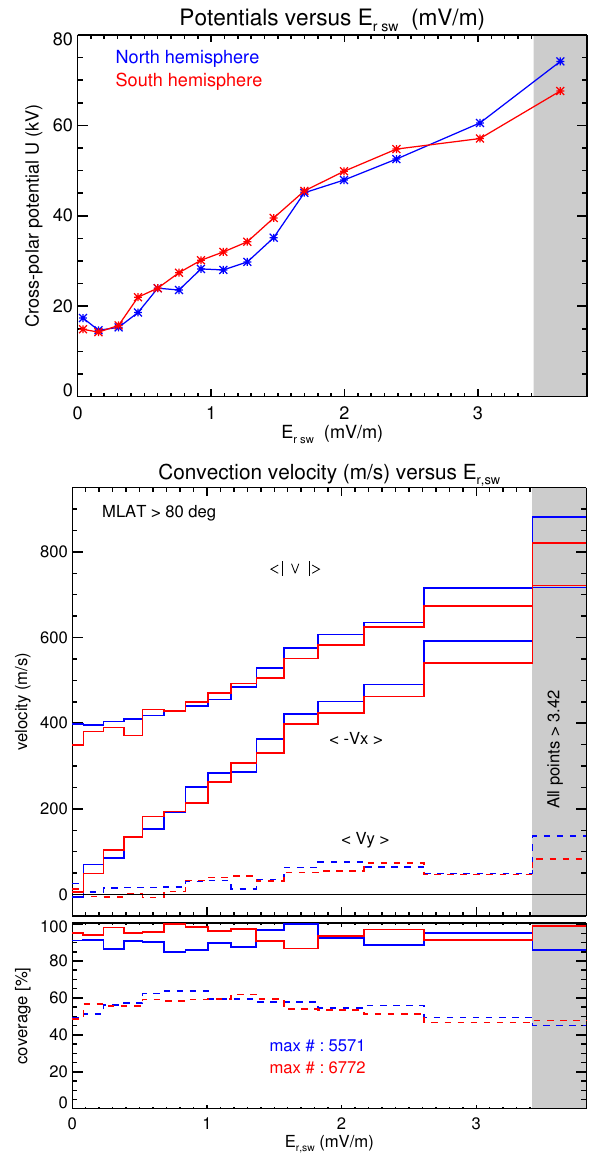
Fig. 9. Top: Cross-polar cap potentials as function of the solar wind reconnection electric field, E r,sw , for both North (blue) and South (red) high-latitude convection pattern, derived for each bin separately (cf. Paper 1). Here, again we use variable step widths as in Fig. 8. Middle: Central polar cap convection velocities for the same variable bin steps as above, but averaged within the central polar cap at magnetic latitudes at | φ m | > 80 ◦ only. The bottom panel shows the coverage characteristics for each bin like in Fig. 7.